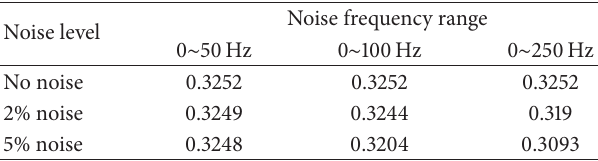
Table 2: Noise effects on Lipschitz exponent (seismic